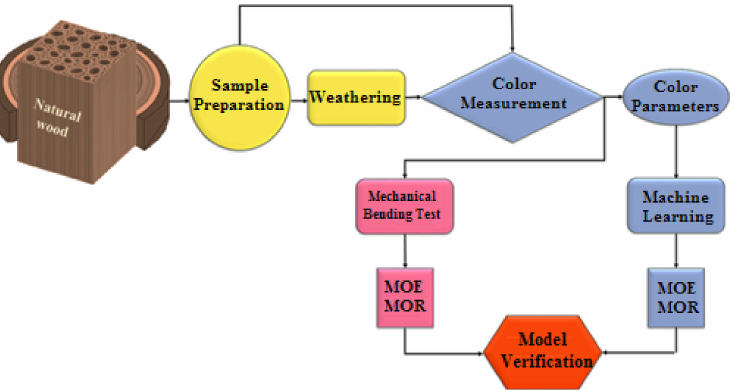
Figure 2. Flowchart of the proposed methodology to monitor the mechanical properties of the weathered wood by color